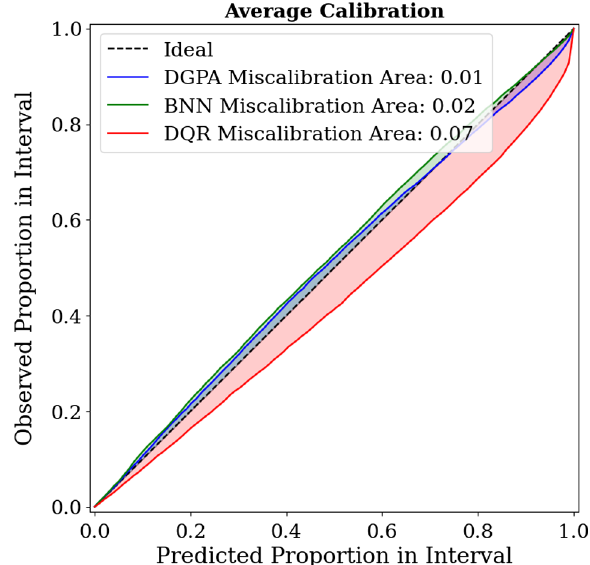
FIG. 4. Comparison of miscalibration between DGPA, BNN, and DQR for in-distribution data. The shaded area represents the amount of miscalibration in the uncertainty estimation with respect to the true